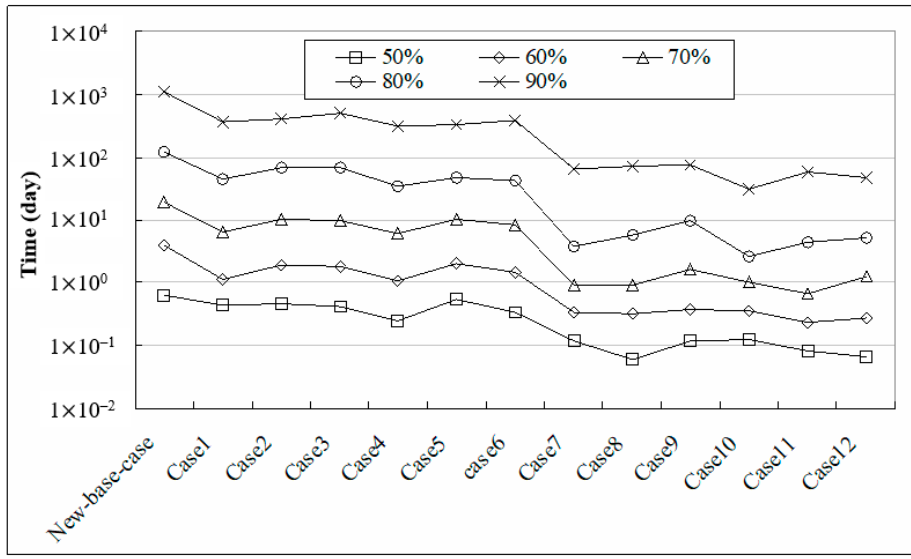
Figure 6. Required time for different percentages of head recovery for the heterogeneous cases (note: “New base case” in this figure denotes the new base case).